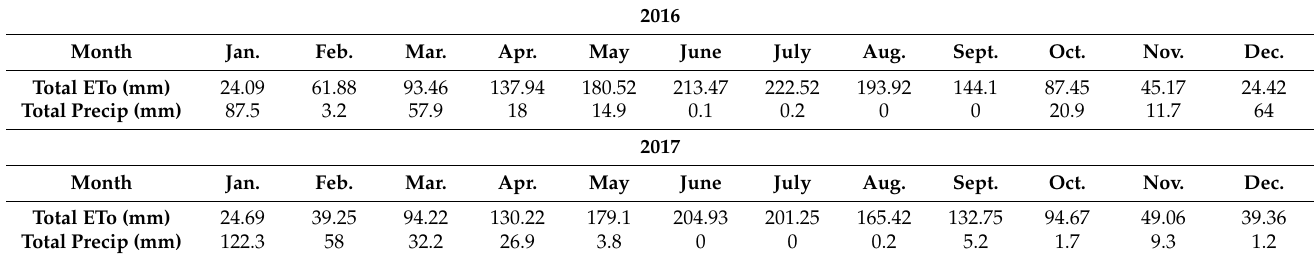
Table 2. Total monthly of precipitation (Precip) and evapotranspiration (Eto) of the experimental site (Parlier, CA, USA) during 2016 and 2017 seasons. Data obtained from CIMIS (https://cimis.water.ca. gov/ (accessed on 21 January